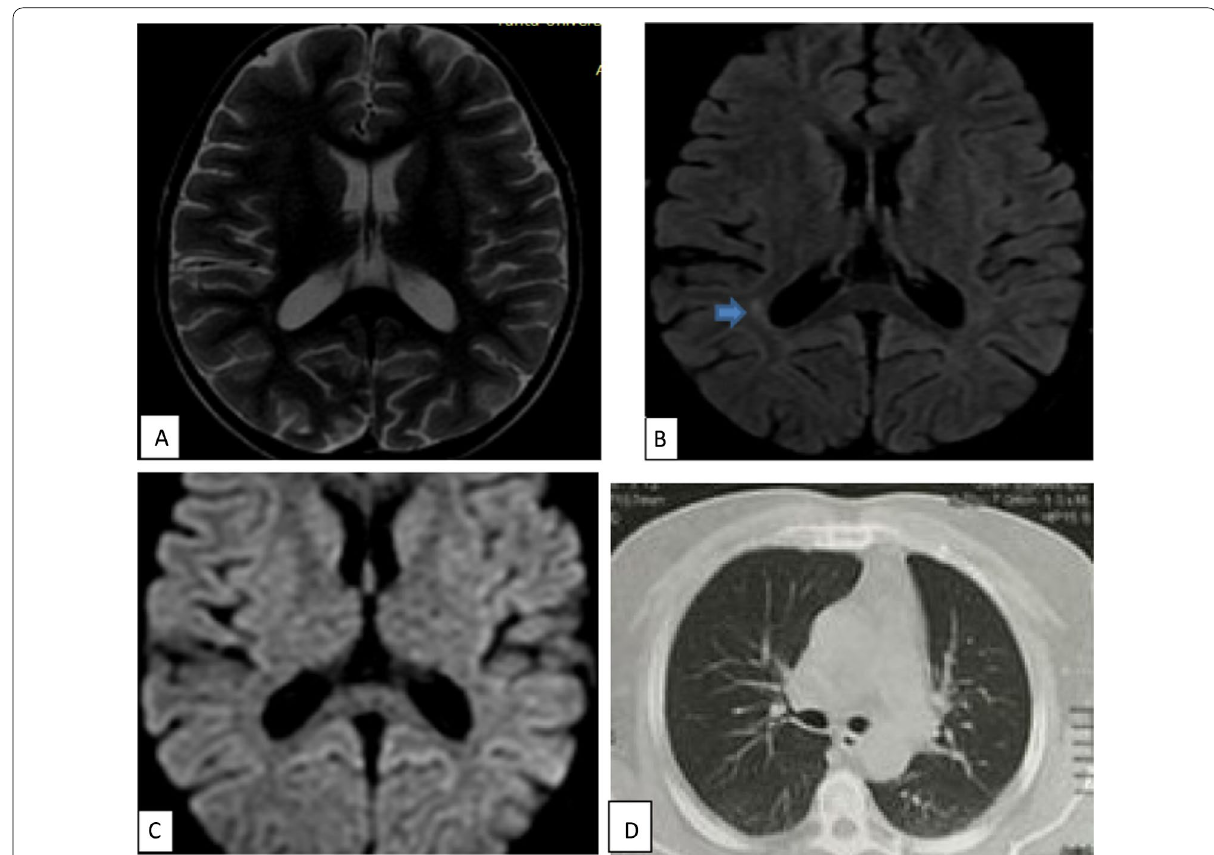
Fig. 5 A 17-year-old female patient with chronic kidney disease presented with post COVID puerperal skin rash, headache and decreased conscious level. MRI axial T2WI ( a ) hardly detect abnormal signal and axial FLAIR ( b ) revealed abnormal foci of increased signal intensity in right periventricular deep white matter (blue arrows). Diffusion images ( c ) show no restricted diffusion. Post COVID vasculitis was considered. CT chest during acute phase not shown. CT chest at time of admission show no abnormalities